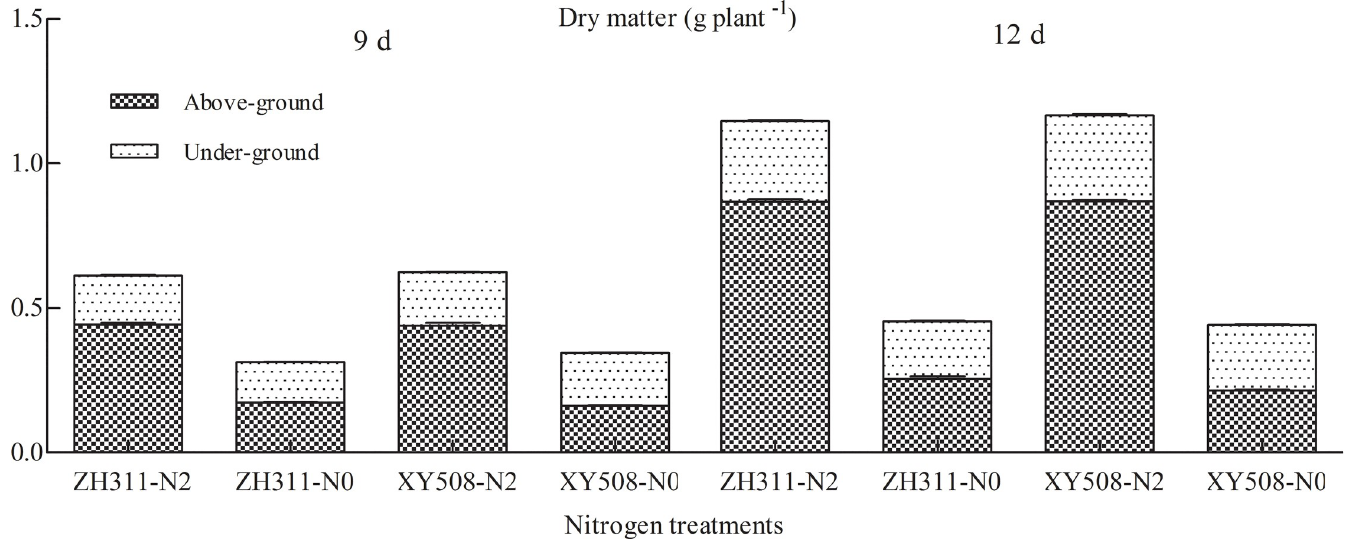
Fig 2. Dry weight per plant of maize in the seedling stage under different nitrogen treatments (2016). Note: N0, 0.04 mM; N2, 4